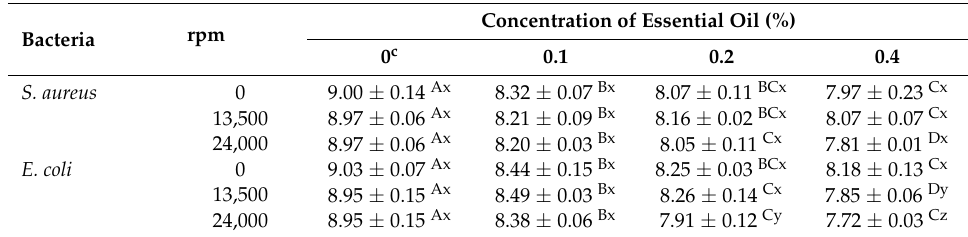
Table 2. Effect of homogenization speed and concentration of emulsified pomelo peel oil on the viability of S. aureus and E. coli (Log CFU/mL) a,b